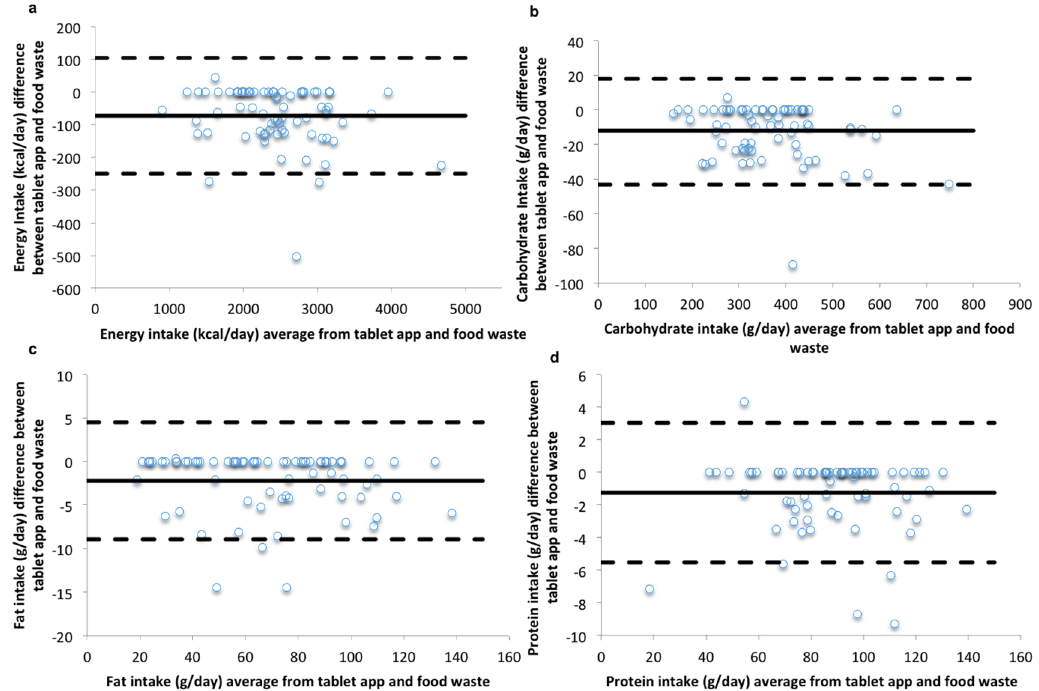
Figure 1. Repeated Measures Bland ‐ Altman plots of the difference between intakes recorded by the tablet app and those from the measured food intake/food waste method against the mean values for the two methods for ( a ) energy; ( b ) carbohydrates; ( c ) fat; and ( d ) protein. The solid line indicates the mean difference (energy − 73 kcal/day, carbohydrates − 12 g/day, fat − 2.21 g/day and protein − 1.25 g/day), and the dashed line indicates the 95% Limits Of Agreement (LOA) (1.96 SD) for nutrient intakes (energy − 250 kcal/day, 104 kcal; carbohydrates − 43 g/day, 18 g/day; fat − 8.91 g/day, 4.5 g/day and protein − 5.52 g/day, 3.03 g/day).